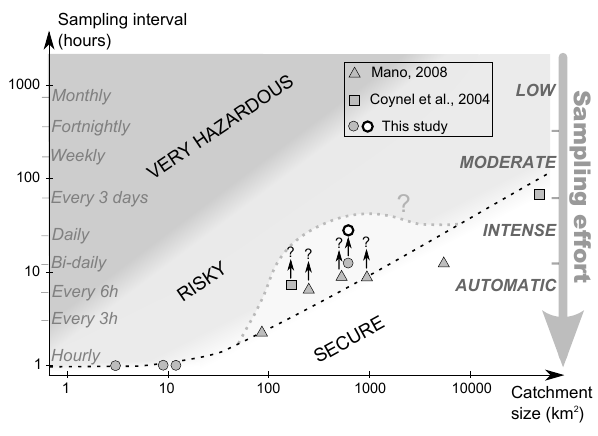
Fig. 7. Minimum sampling frequency requirements for the achieve- ment of reliable SSY estimates. The white area indicates condi- tions allowing high-quality estimates (i.e. maximum errors within ± 20%), the light-grey area corresponds to conditions leading to po- tentially risky estimates (i.e. 25 and 75 quartiles within ± 20%), and the dark-grey area refers to conditions that can induce doubtful cal- culations. Circles correspond to data from this study, squares corre- spond to data from Coynel et al. (2004), and triangles to data from Mano (2008). The rounded dashed grey line in the centre of the fig- ure refers to an elevation of the boundary between secure and risky estimates, which is likely to occur if the sub-daily cycle of sediment fluxes is considered. The shift from a grey to a white circle is an illustration of our results in Undameo (i.e. lowering of the sampling frequency from bi-daily to